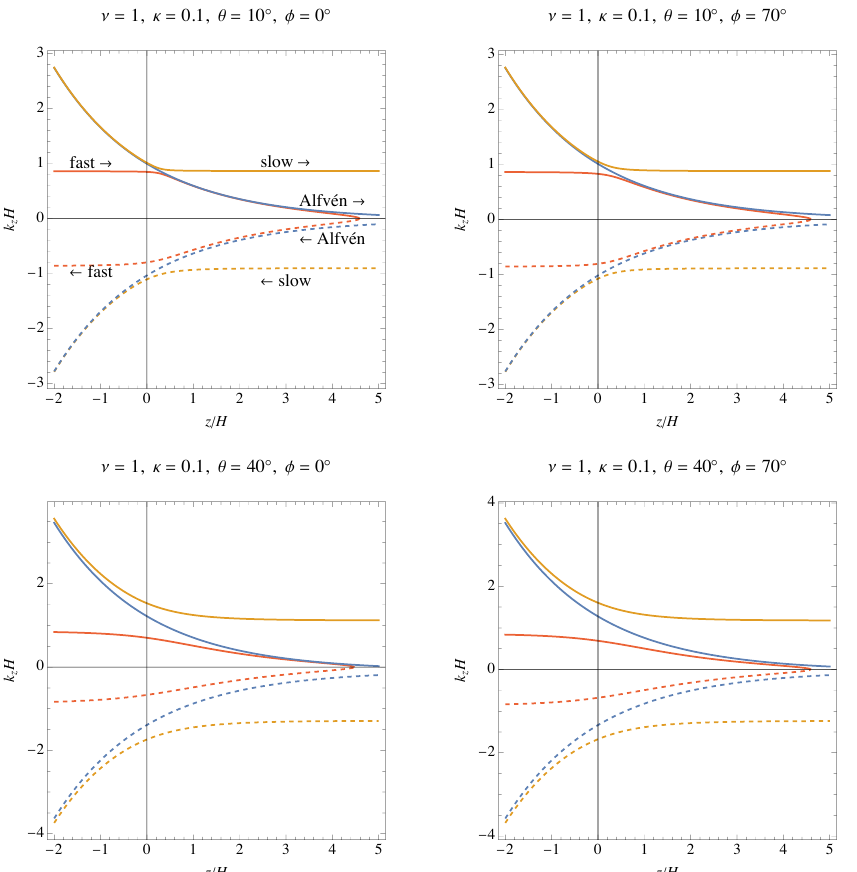
Figure 1. Dispersion diagrams for the case ν = 1, κ = 0.1 and θ = 10 ◦ ( top row ) and θ = 40 ◦ ( bottom row ), with φ = 0 ◦ ( left column ) and φ = 70 ◦ ( right column ). The slow wave loci are plotted in orange, the Alfvén wave in blue and the fast wave in red, with full curves corresponding to upgoing waves, and dashed to downgoing. Labels indicate wave types and directions in the top left panel. The a = c equipartition is at z = 0. See text for